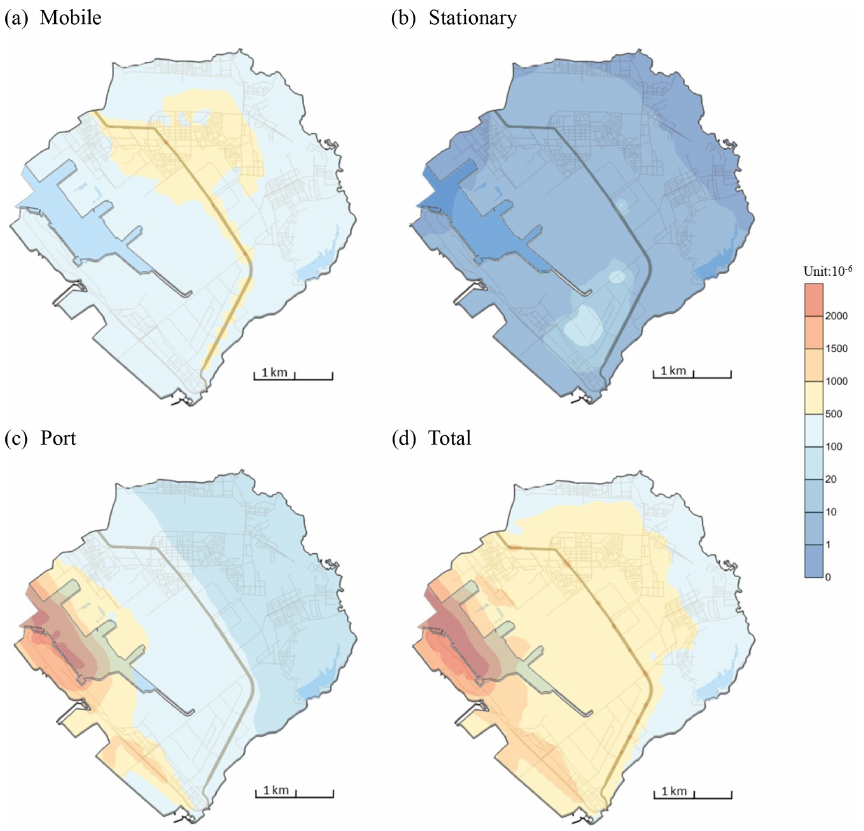
Figure 3. Spatial distribution of carcinogenic risk among all sources. Table 1. Emissions of hazardous air pollutants (kgyr − 1 ) from various